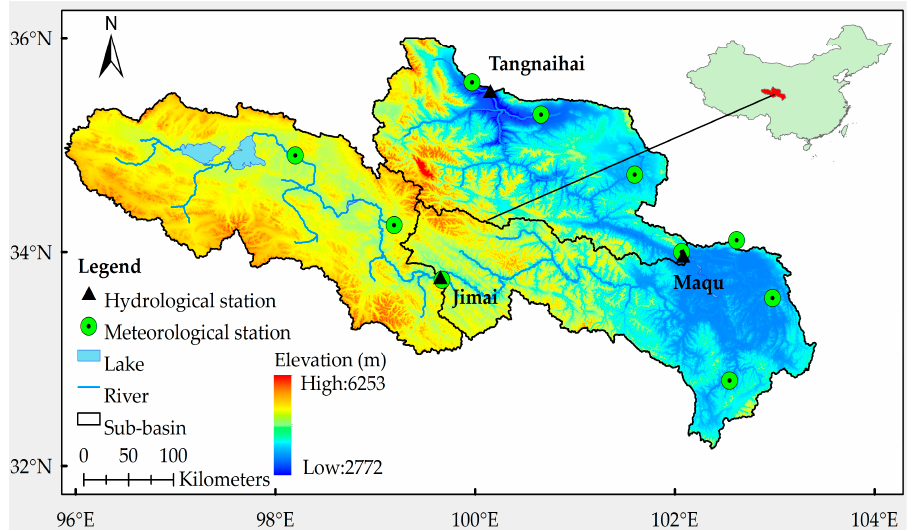
Figure 1. Location of the upper Yellow River basin (UYRB). The hydrological station and the meteorological station used in paper are also shown in the figure. Table 1. The major information about the three hydrometric stations.